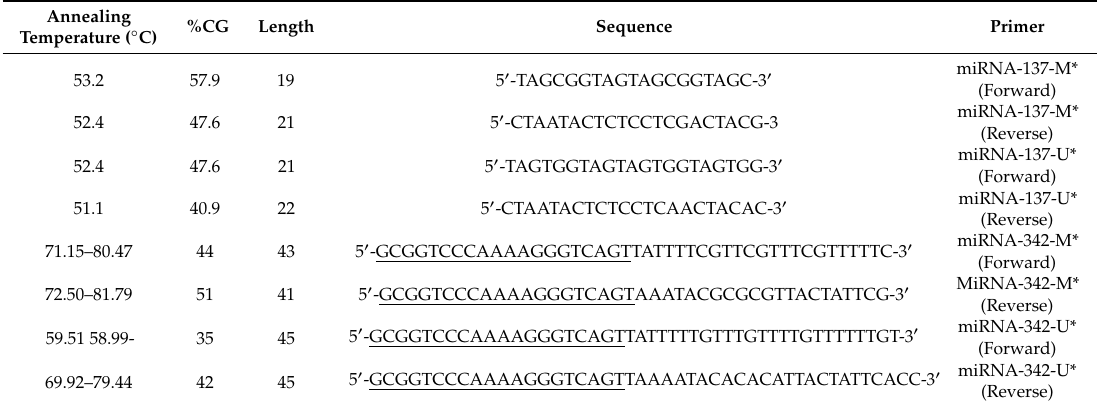
Table 3. Methylation-specific PCR primer